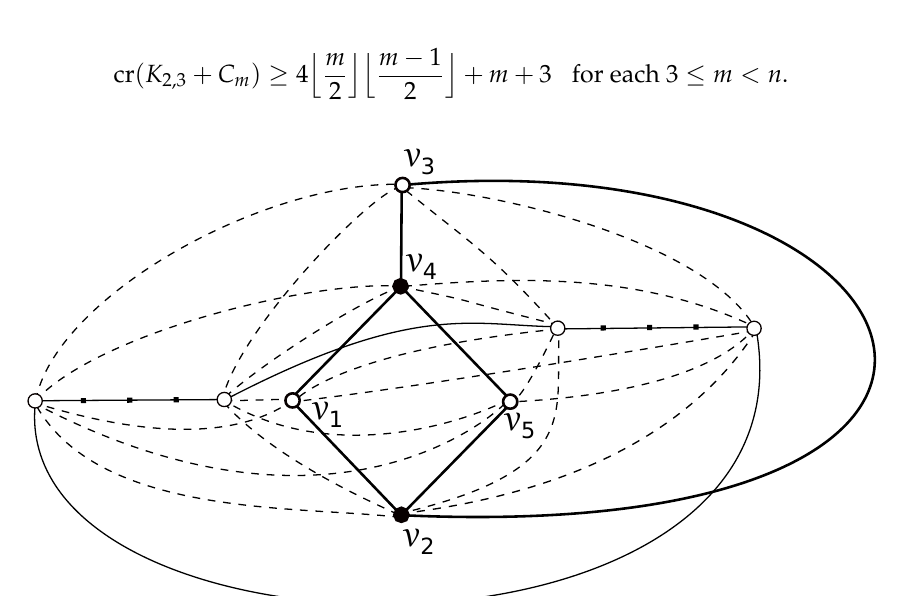
(cid:4) n (cid:5)(cid:4) n − 1 (cid:5) + n + 3 2 2